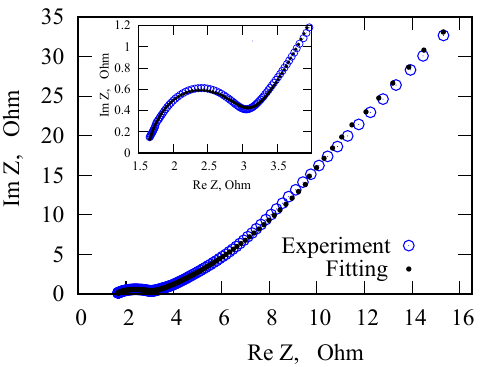
Figure 5. Nyquist plot for PANI/VA-MWCNT